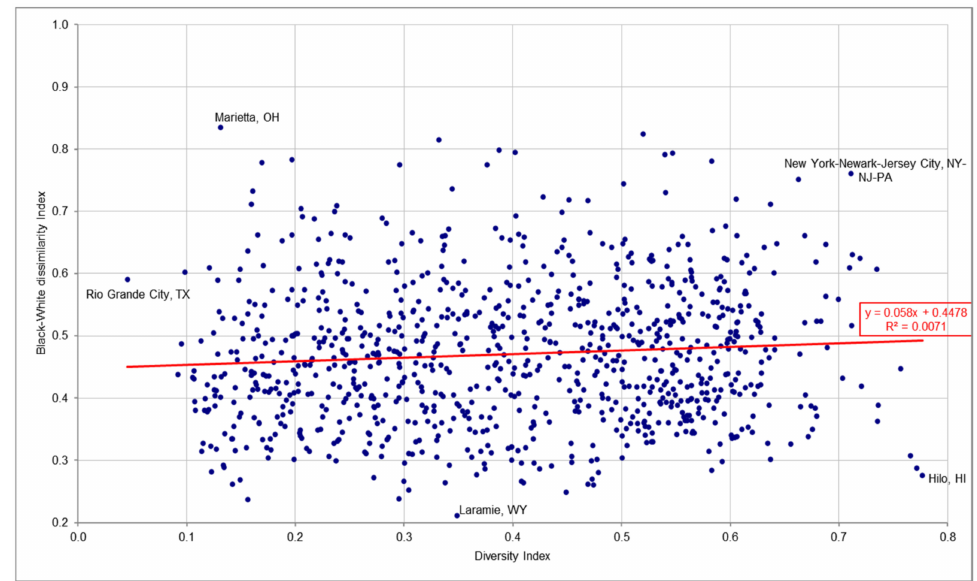
Figure 22. Relationship Between Diversity and Black-white Dissimilarity.